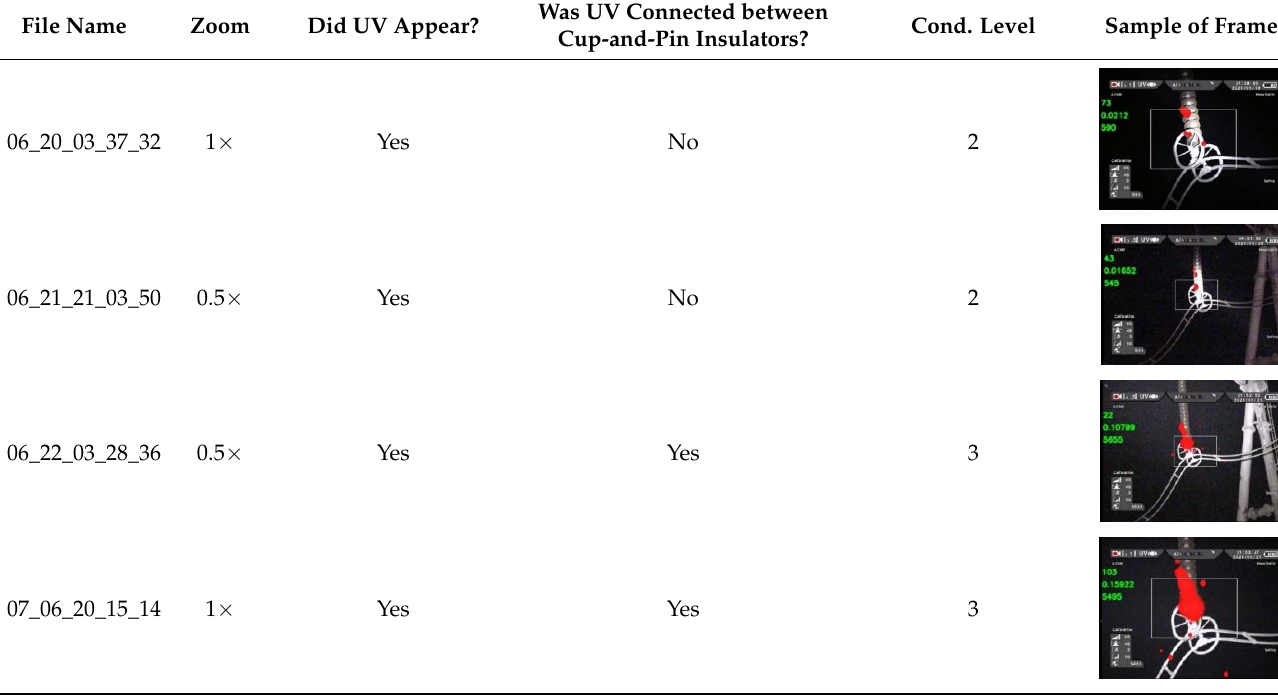
Table 3. Visual-based assessment results for S phase suspension string at the GIS area.